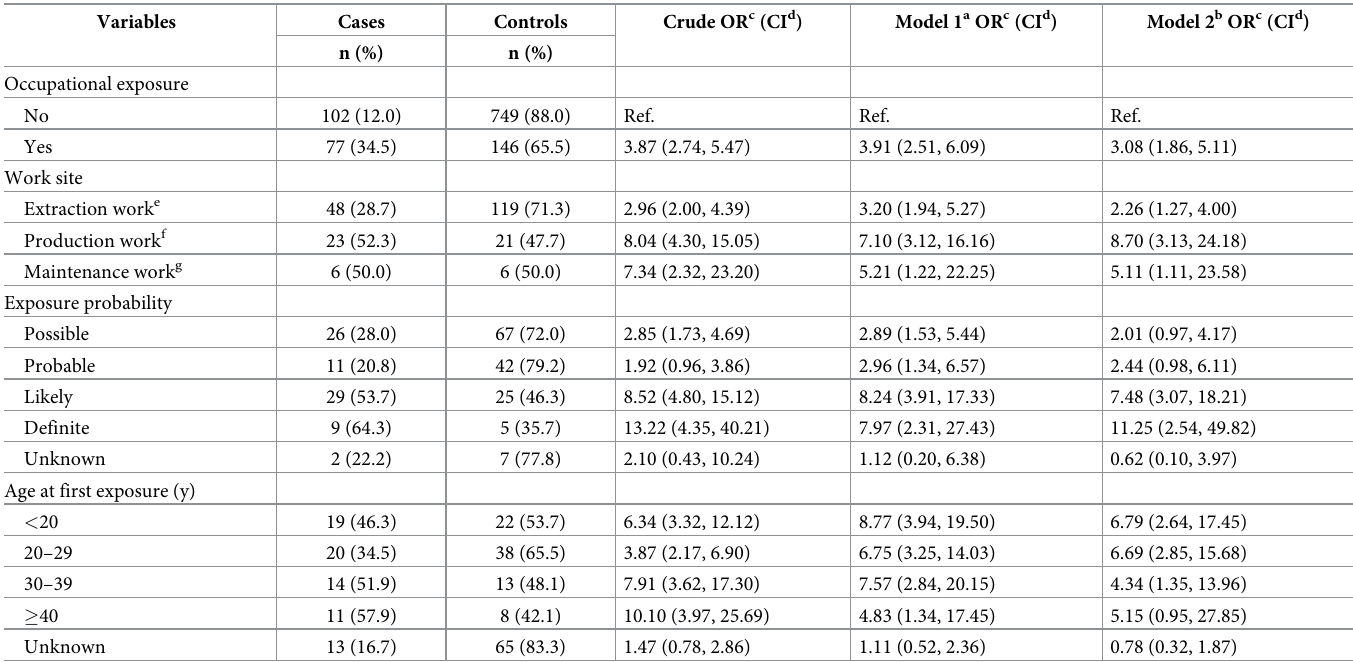
Table 3. Risk of lung cancer according to occupational asbestos